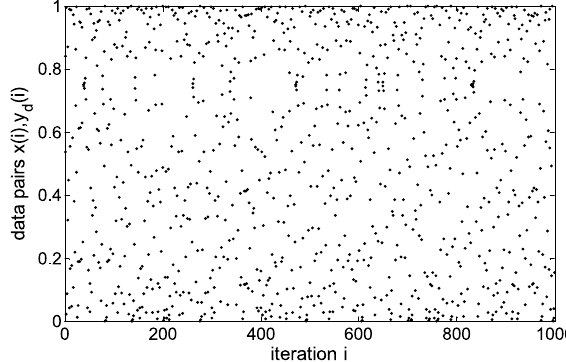
Fig. 2. The input-output data pairs of the true system.